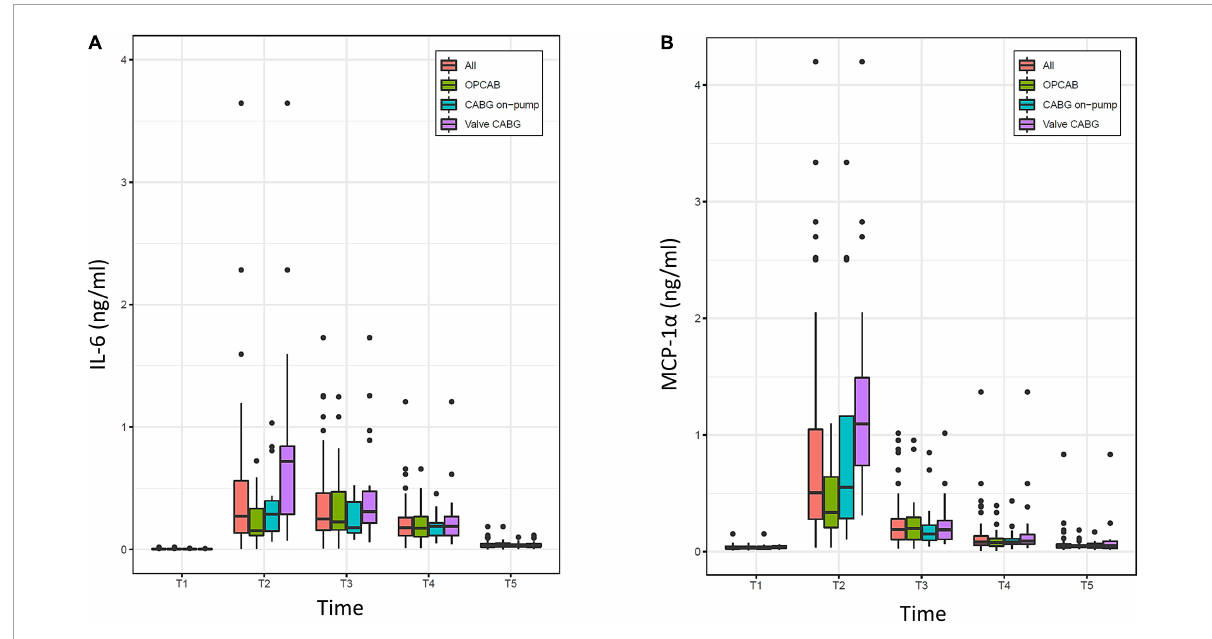
FIGURE5 Evolution of (A) interleukin-6 (IL-6) and (B) monocyte chemoattractant protein 1 α (MCP-1 α ) over time (T1–T5) in the overall population (All) and the three groups (OPCAB, CABG on-pump and valve-CABG). Values are presented as median and interquartile range (IQR) (box), within 1.5 × IQR (line) and outliers (dots). T1, baseline; T2, time of intensive care unit (ICU) admission; T3, 4 h after surgery; T4, 8 h after surgery; T5, 48 h after surgery; CABG, coronary artery bypass grafting; OPCAB, off-pump coronary artery bypass